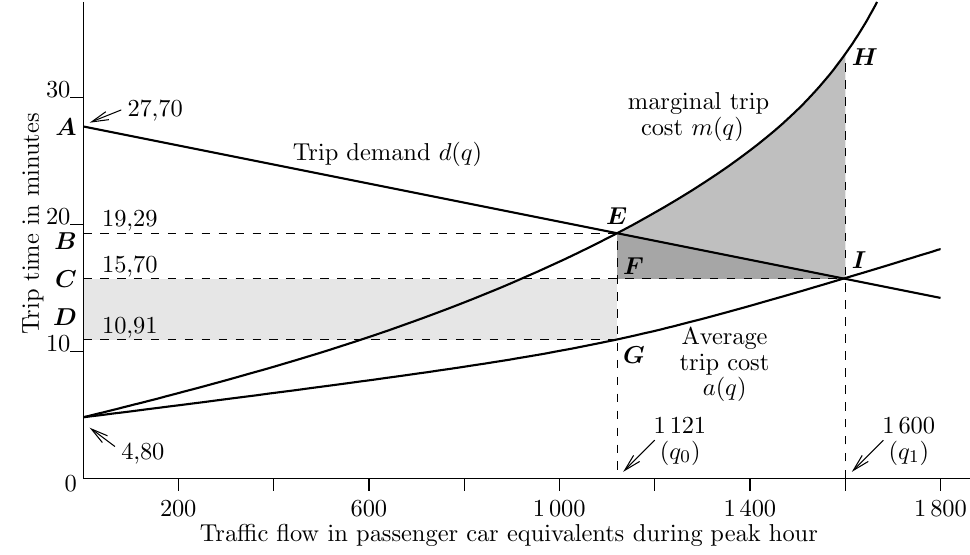
Figure 1: Private car trips to the central business district of Cape Town on the N1-route during the morning peak hour: cost and demand